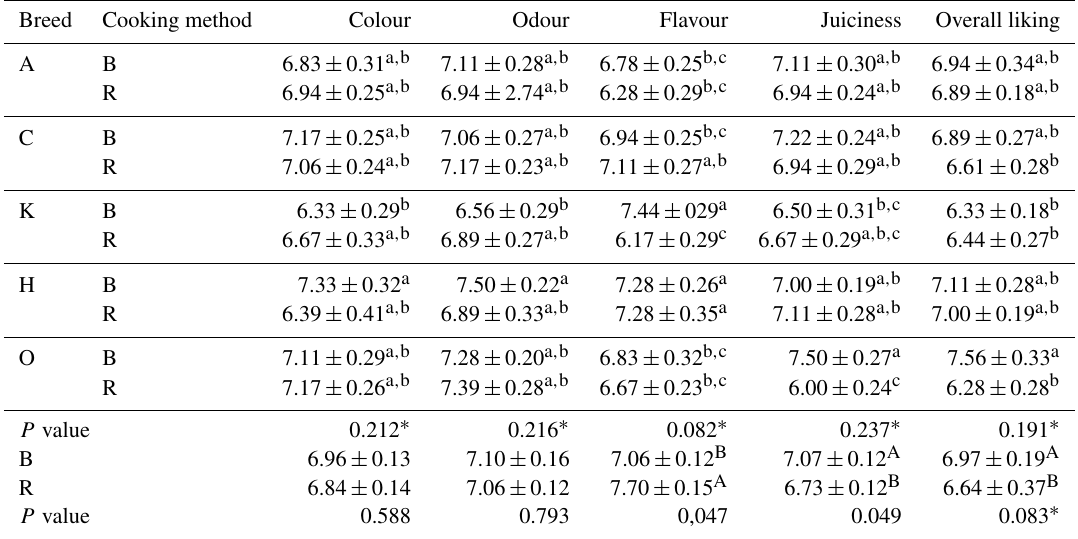
The abbreviations listed in the table are as follows: A – Artlı, C – Çepni, K – Karayaka, H – Hem¸sin, O – Of, B – boiled, and R – roasted. A , B and a , b , c denote the presence or absence of a significant difference: values within a column without a common superscript letter differ significantly ( P <0.05). “ ∗ ” denotes that, although there was no difference between the sensory evaluations according to the analysis of variance, there were differences in the Duncan multiple comparison